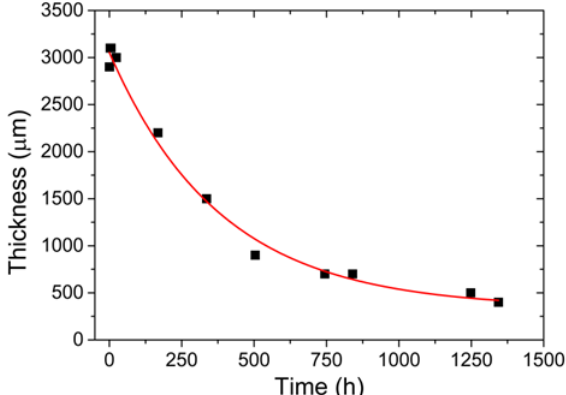
Figure 3. Thickness variation of the metal plate as a function of the corrosion time. Through the collected results, the curve corresponding to the variation of the